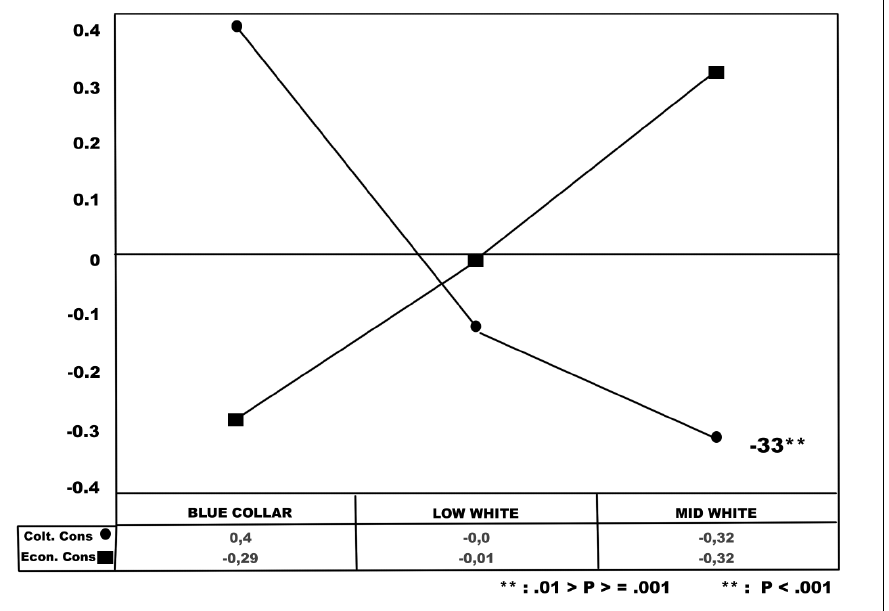
Factor scores of the three occupational groups for socio-cultural and socio-economic conservatism